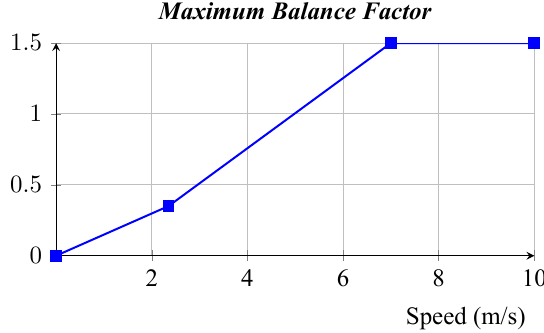
Figure 5. Maximum balance factor curve, as a function of the bike’s